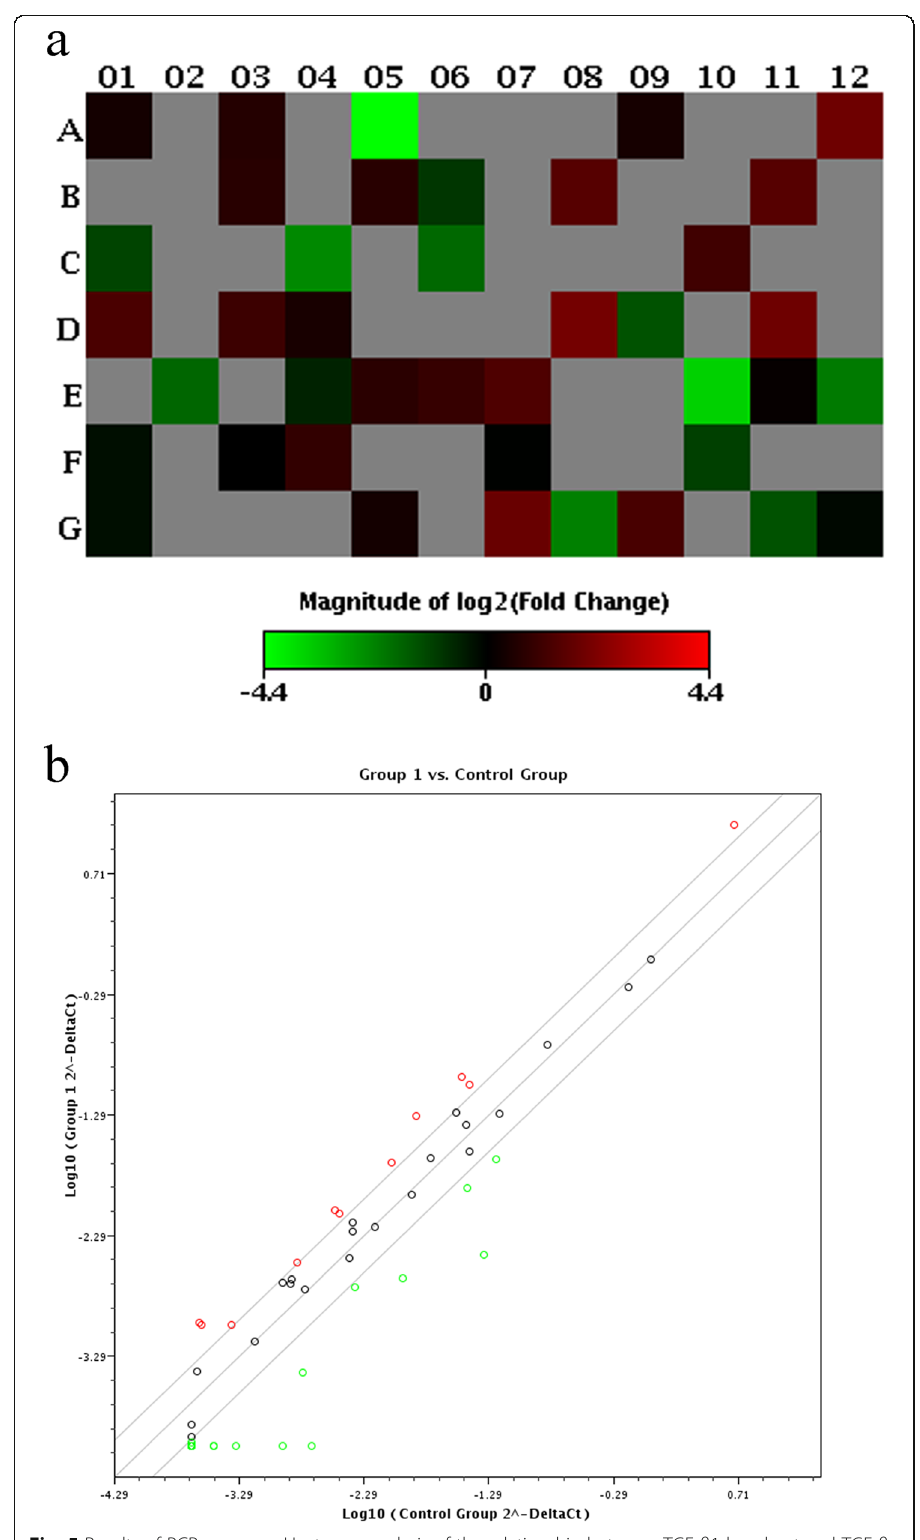
Fig. 5 Results of PCR array. a – Heat map analysis of the relationship between TGF- β 1 knockout and TGF- β pathway-related gene expression. b – Scatter plot analysis of the relationship between TGF- β 1 knockout and TGF- β pathway-related gene